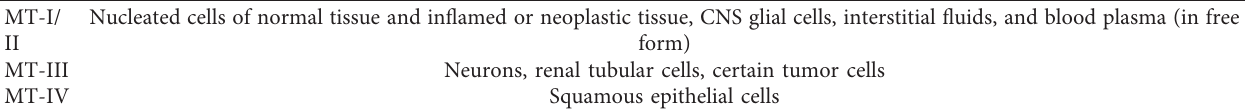
Table 1: Occurrence of different isoforms of human metallothioneins (MTs).